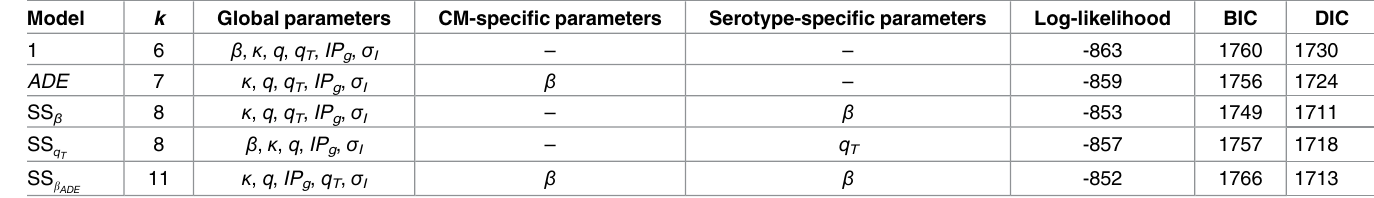
Table 4. Models fit to subset of the data containing viral peaks (N = 65 individuals, n = 747 viral load data points). The parameters estimated, the median log-likelihood values, BIC and DIC values for each model are